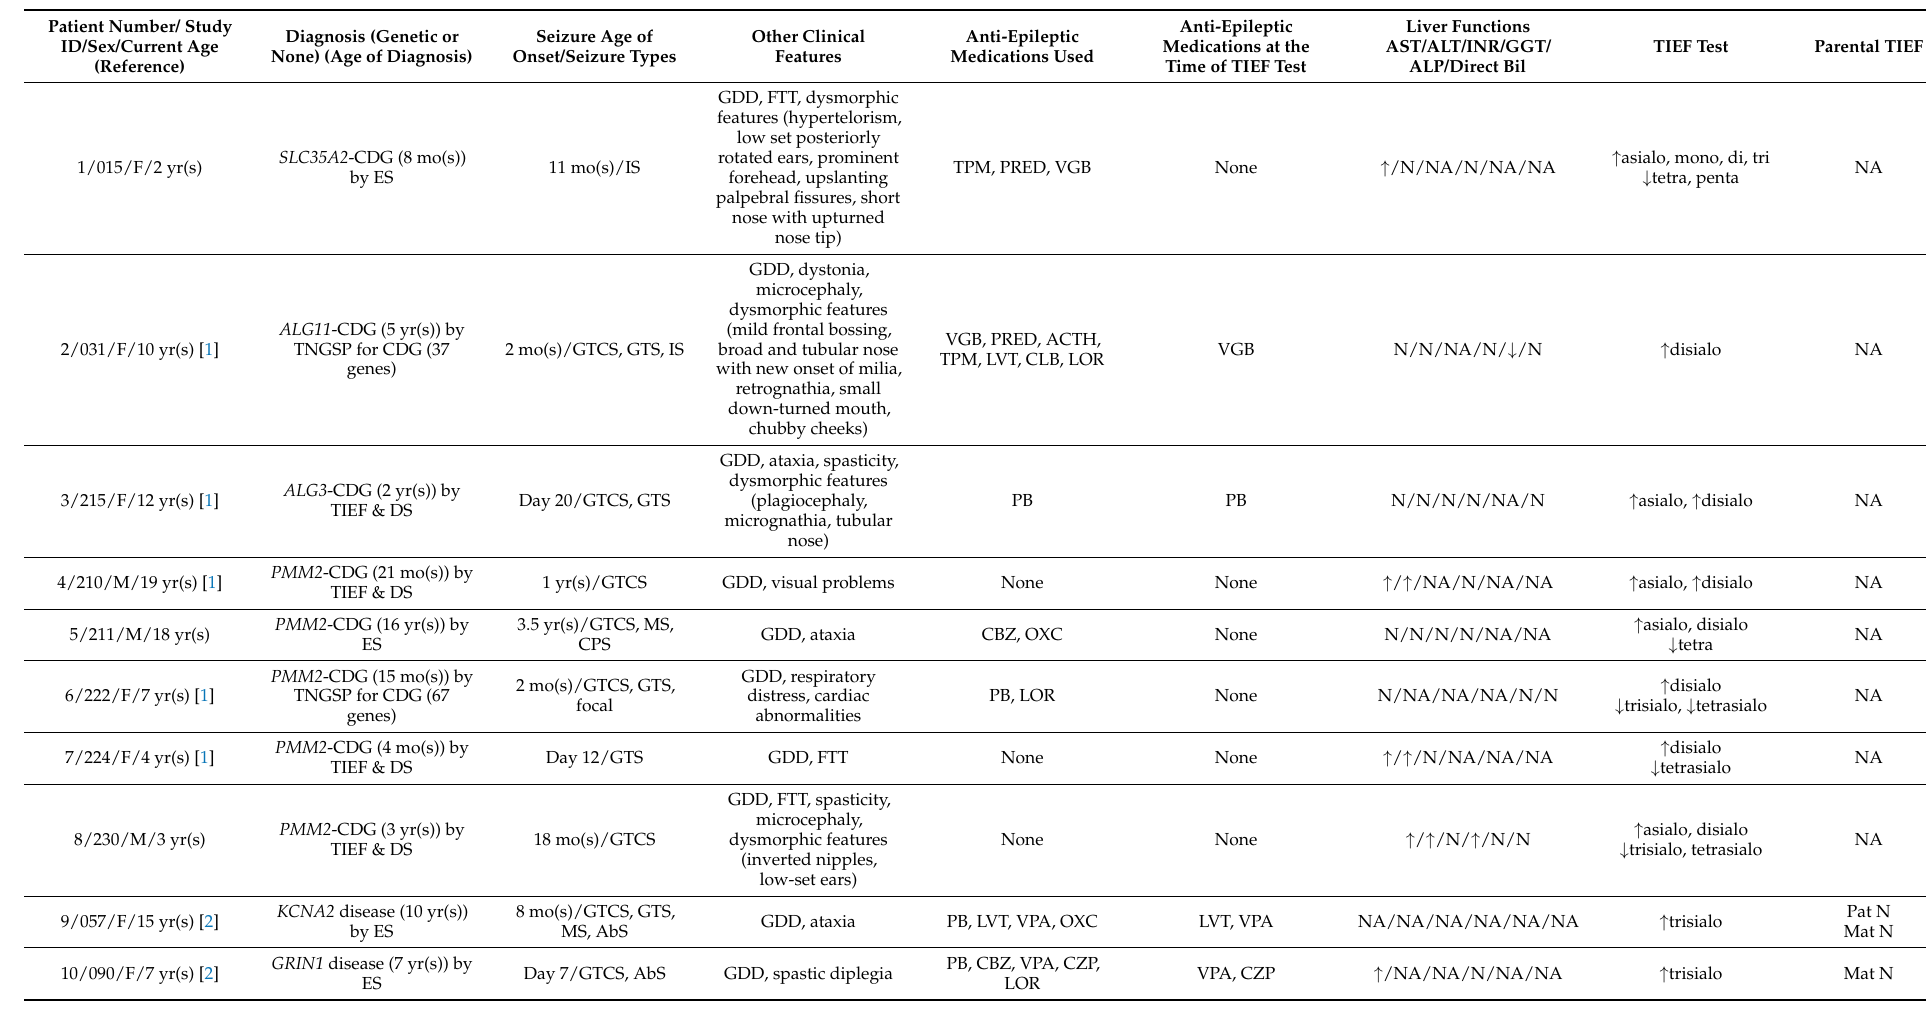
Table 1. All patients with abnormal transferrin isoelectric focusing tests, their clinical features, liver functions, and transferrin isoelectric focusing results are